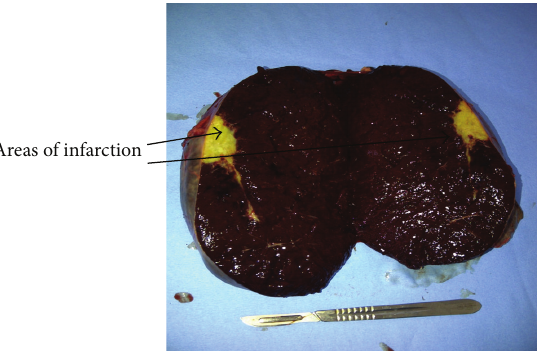
Figure 2: Cut specimen of massive accessory spleen showing mostly normal splenic tissue with some yellow areas of infarction.